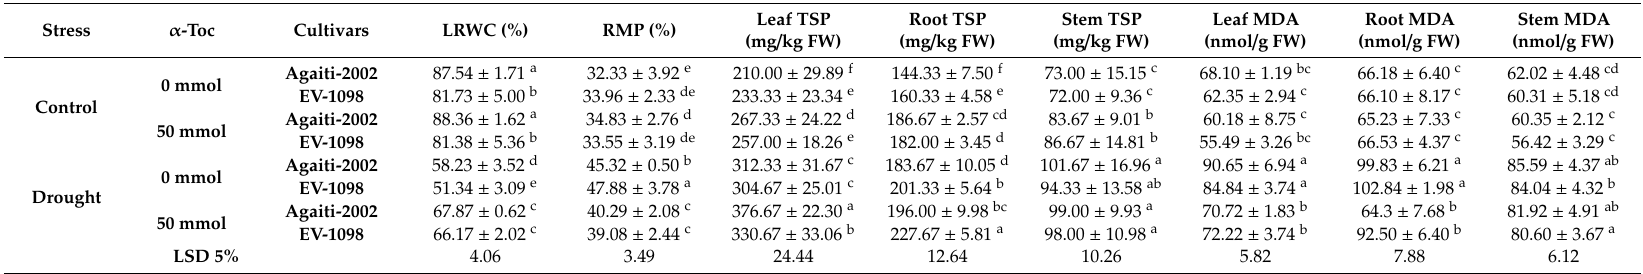
Table 4. Influence of foliar application of α -Toc on leaf relative water content, leaf relative membrane permeability, tissue specific total soluble proteins and malondialdehyde content of maize cultivars grown under di ff erent water regimes (mean ± SE; n = 3). LRWC = leaf relative water content; RMP = leaf relative membrane permeability; Leaf TSP = leaf total soluble proteins; Root TSP = root total soluble proteins; Stem TSP = stem total soluble proteins; Leaf MDA = leaf malondialdehyde; Root MDA = root malondialdehyde; Stem MDA = stem